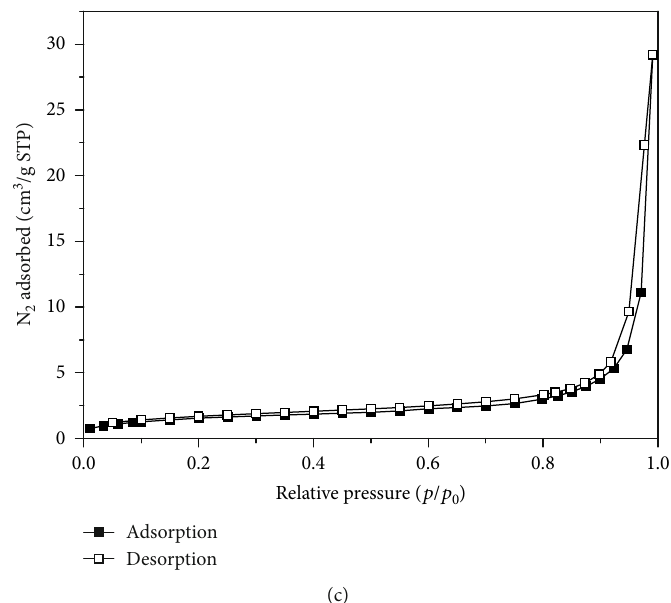
Figure 4: N adsorption-desorption isotherms of CPEI-1 (a), CPEI-2 (b), and CPEI-3 (c). 2